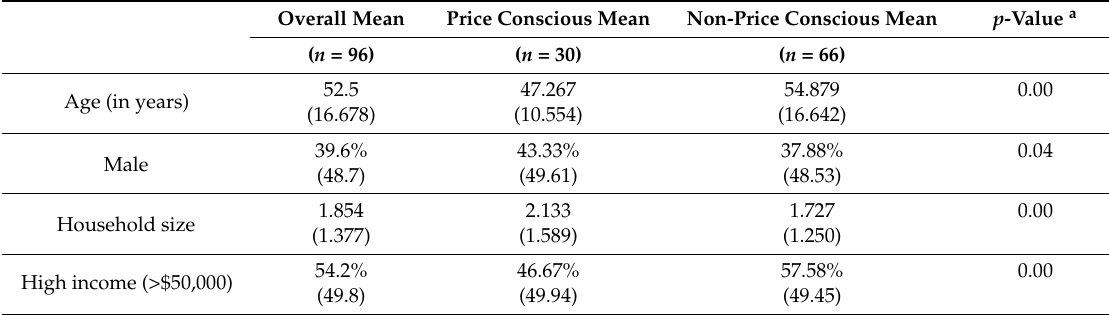
Table 1. Socio-demographic characteristics of the sample participants ( n =